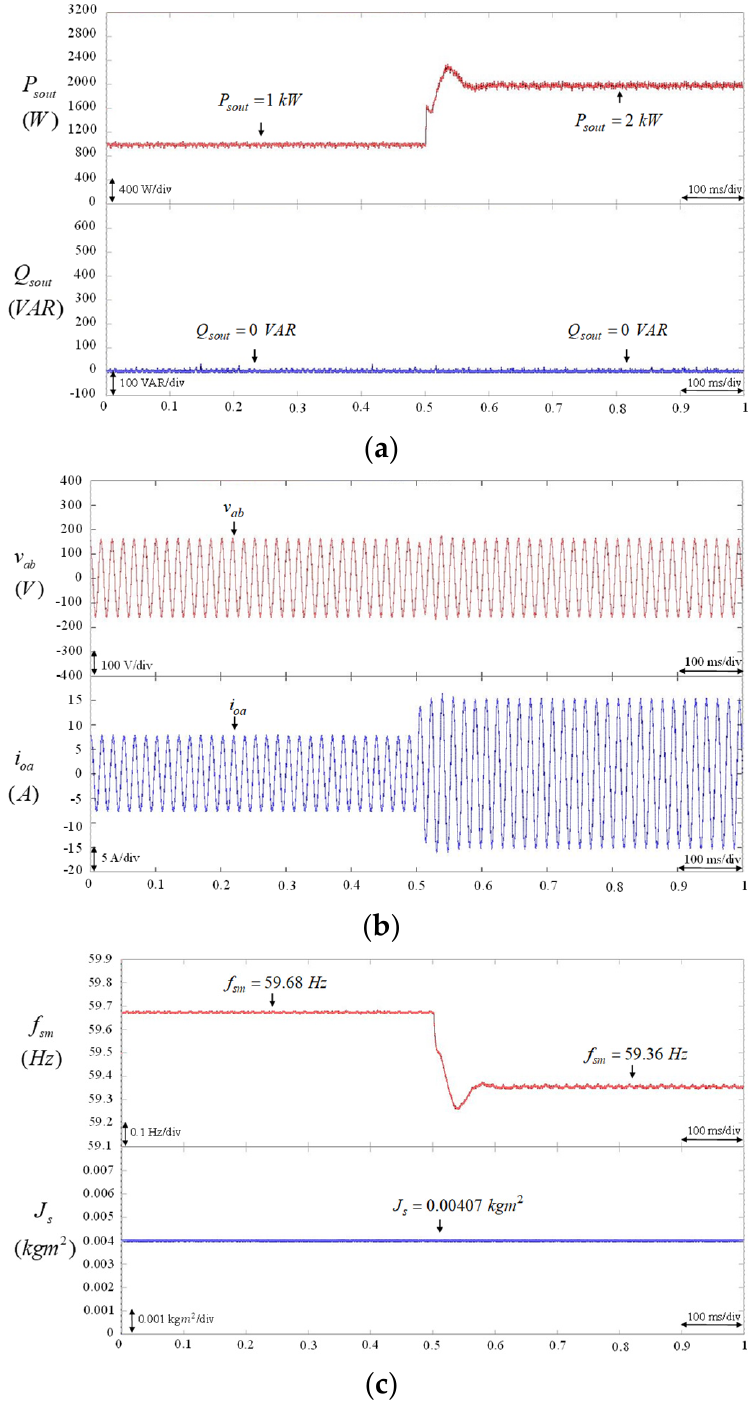
2 kgm . ( a ) Responses Figure 7. BESS using VSG control with constant virtual inertia J s = 0.00407 kgm 2 . ( a ) Responses of